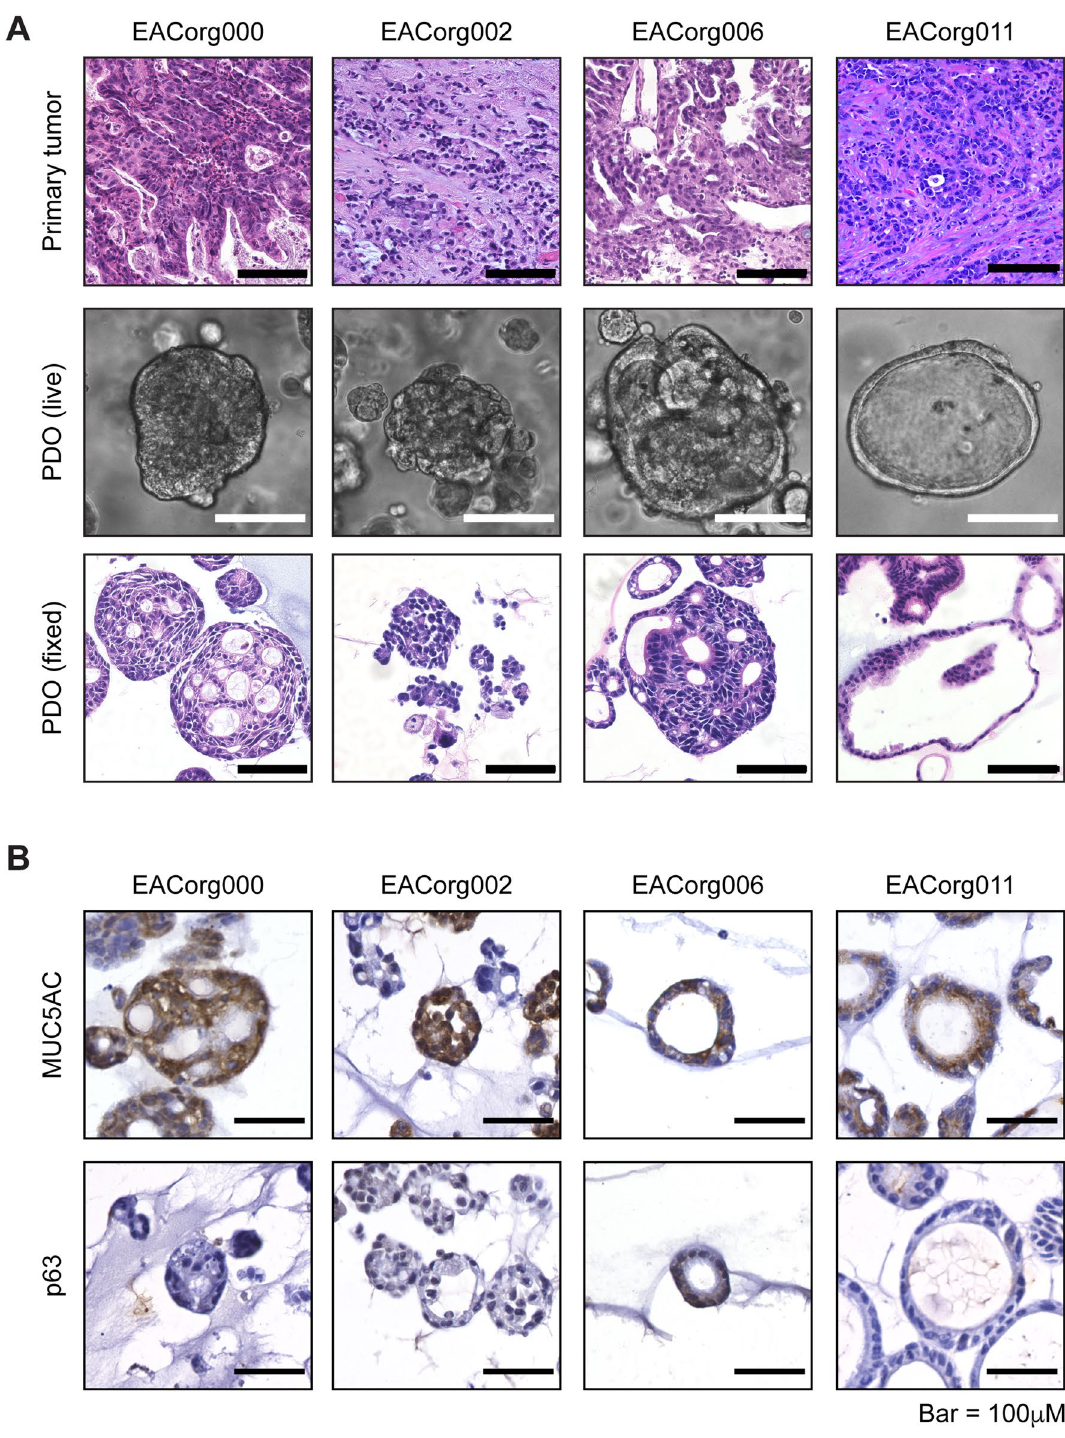
Figure 2. EAC PDOs recapitulate histological features of original tumors. ( A ) Histological features of EAC PDO lines and primary tumors from which they were derived, presented as bright-field images of hematoxylin– eosin stained sections (scale bar = 100 μm). ( B ) Positive cytoplasmic staining for EAC marker MUC5AC and negative nuclear staining for ESCC marker p63 in EAC